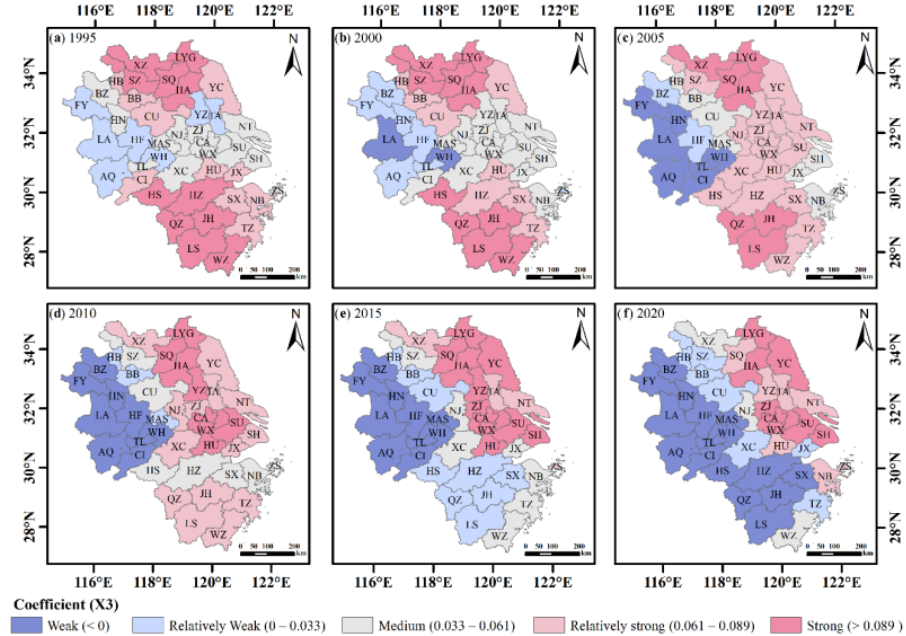
Figure A2. Spatial distribution of the regression coefficients of the land use structure.